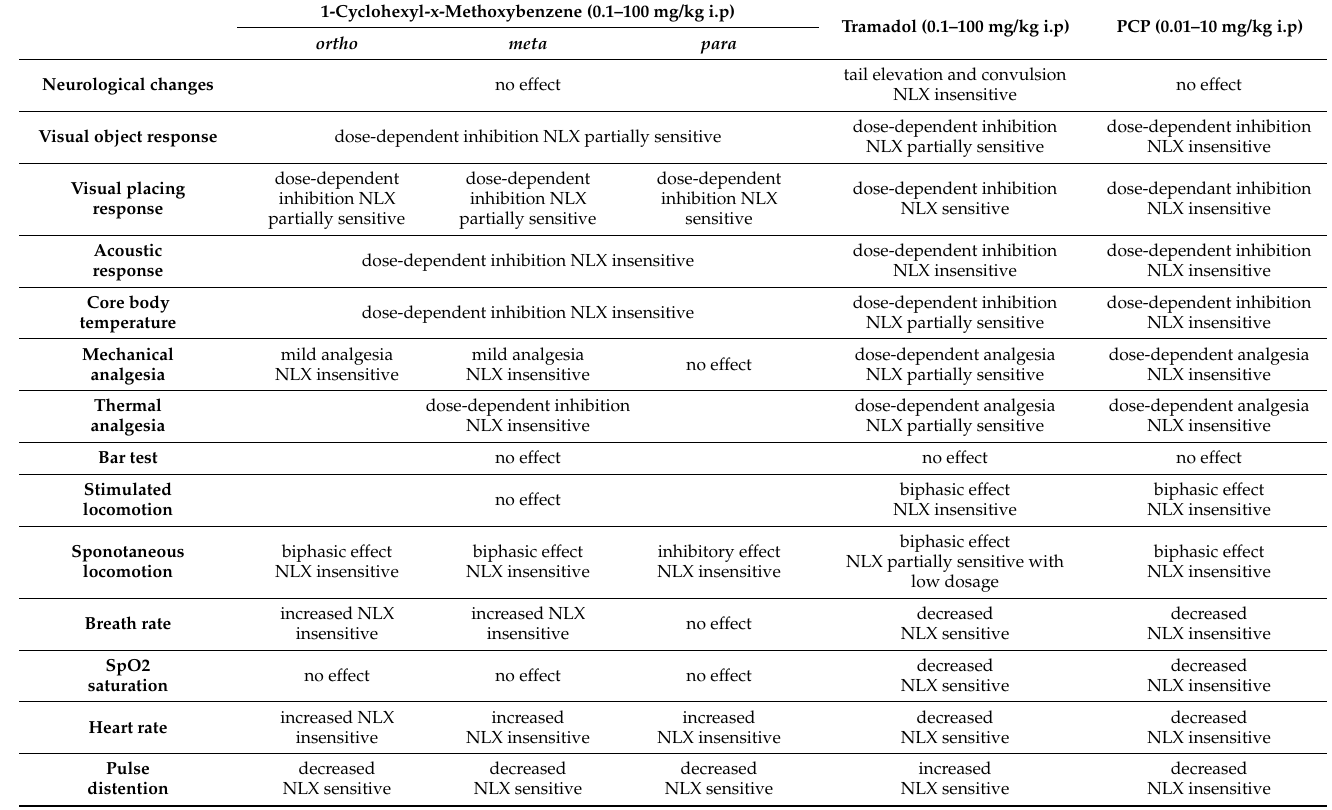
Table 2. Summary of the most important effects induced by the molecules, tested using neurological, behavioral and cardiorespiratory